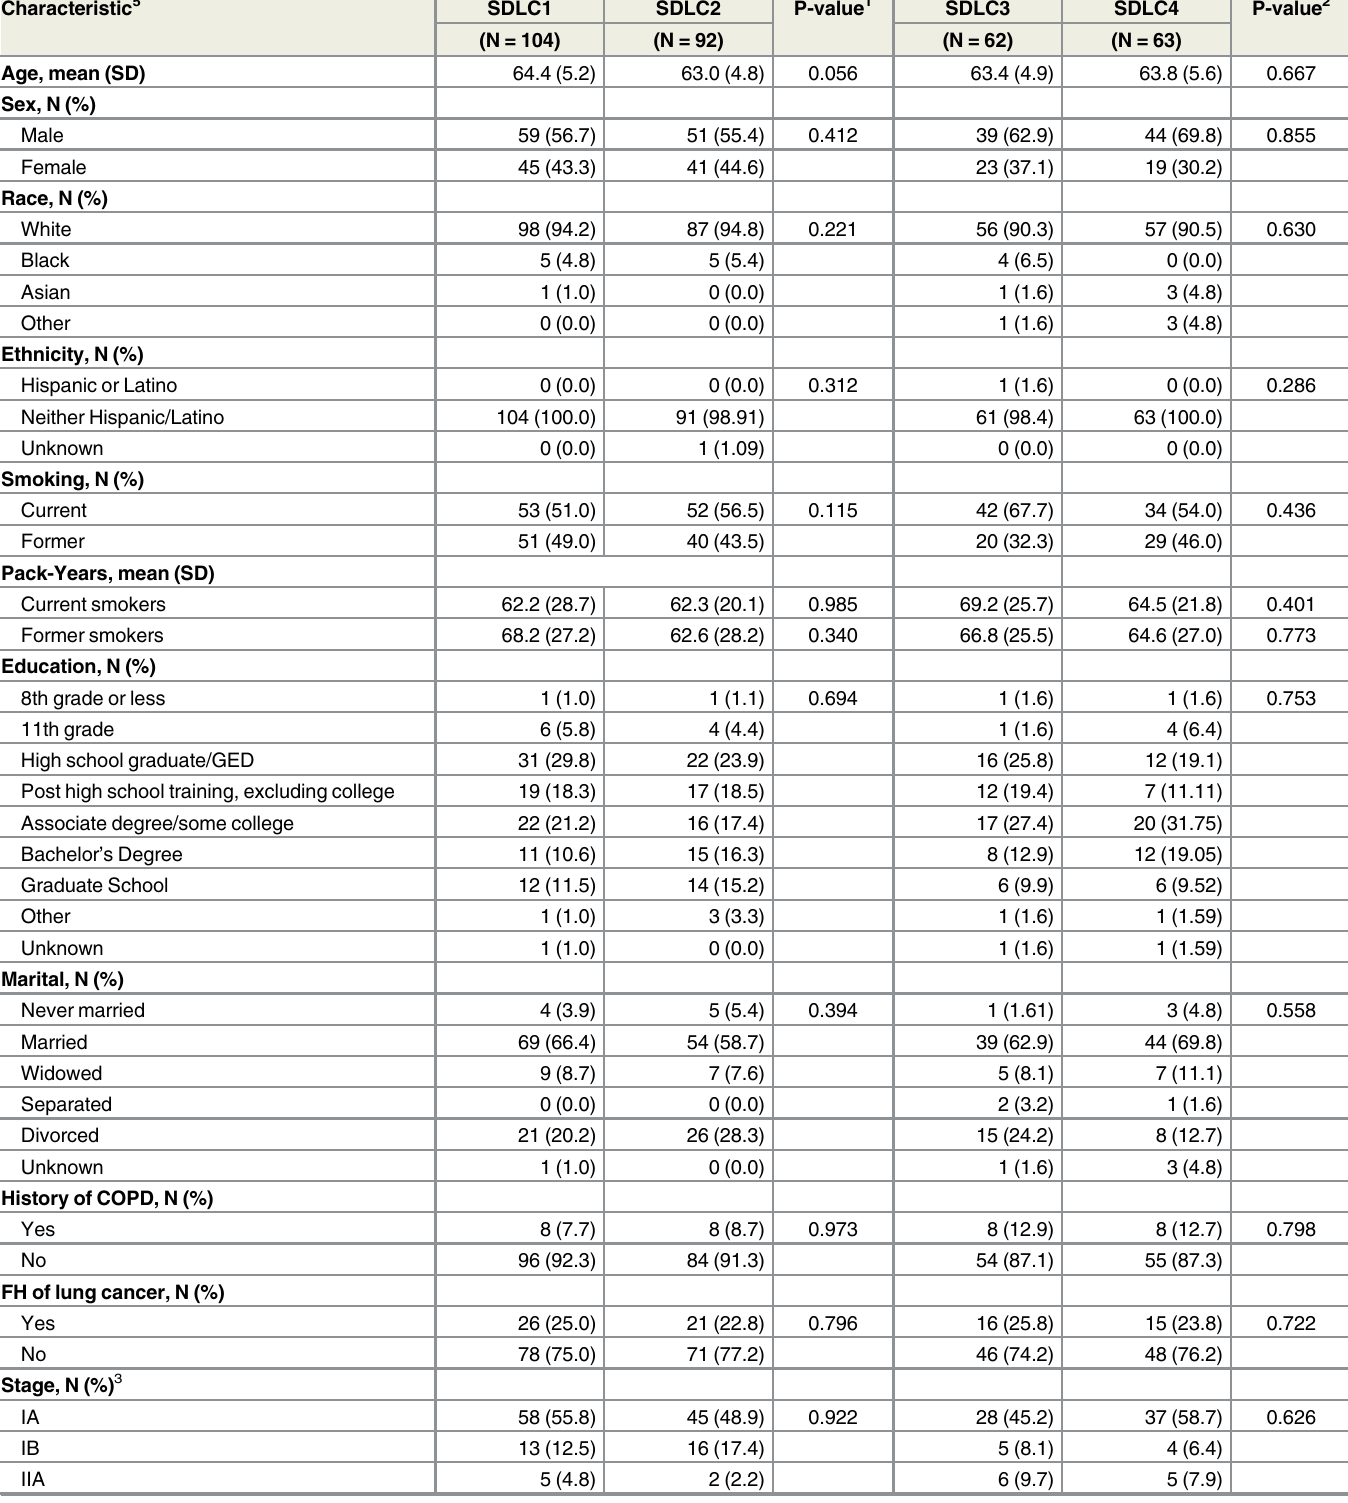
Table 1. Baseline Demographics and Clinical Characteristics of Four Screen-Detected Lung Cancer Case